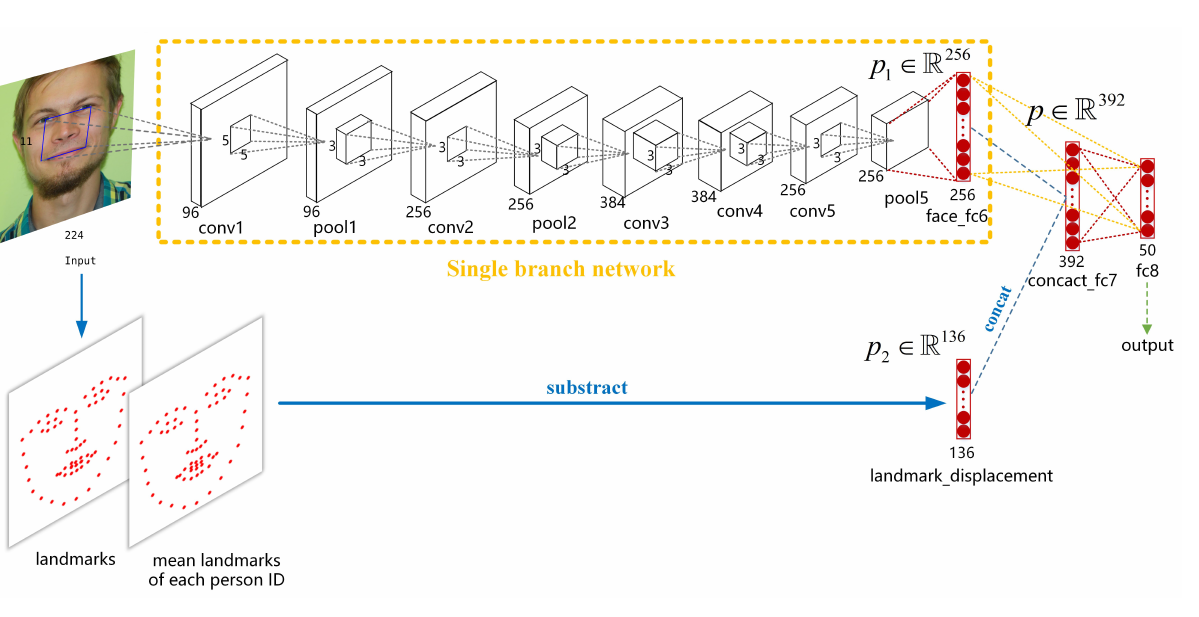
Figure 2. Overview of the 1st-place winner method of the competition. The upper part is a single-branch CNN network. The whole architecture constructs the multimodality network. It is similar to the single CNN, but one more input, named landmark displacement, is added into classifier in the last two layers of the